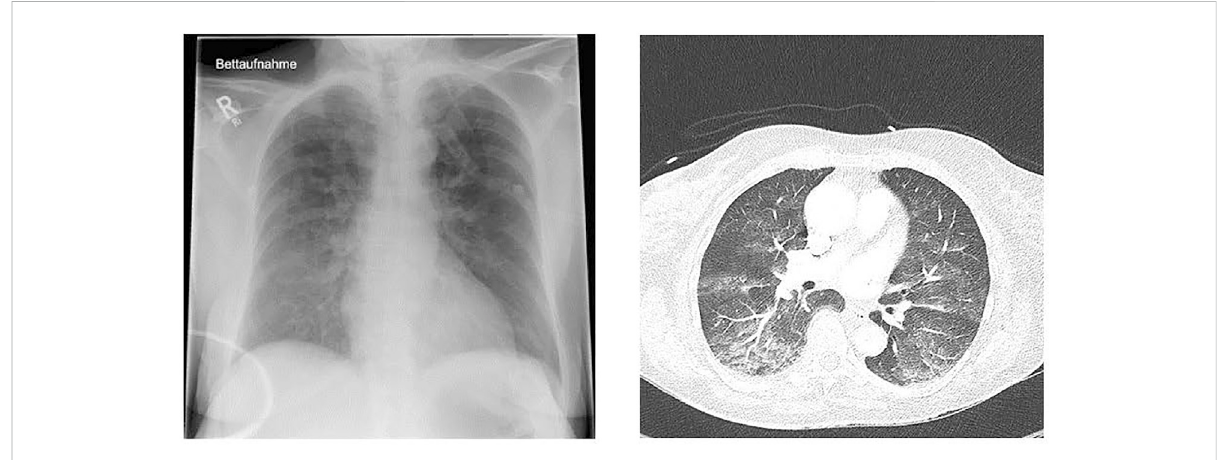
FIGURE 1 Chest x-ray (left) and computed tomography (right) of a 72-year-old previously healthy and physically fi t female after swimming in a cold lake (Courtesy of Karin Hasmiller, MD, Berufsgenossenschaftliche Unfallklinik, Murnau,